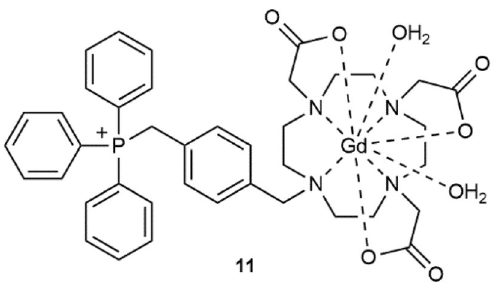
Figure 2. Structure of the previously-reported Gd(III)-DO3A complex 11 .